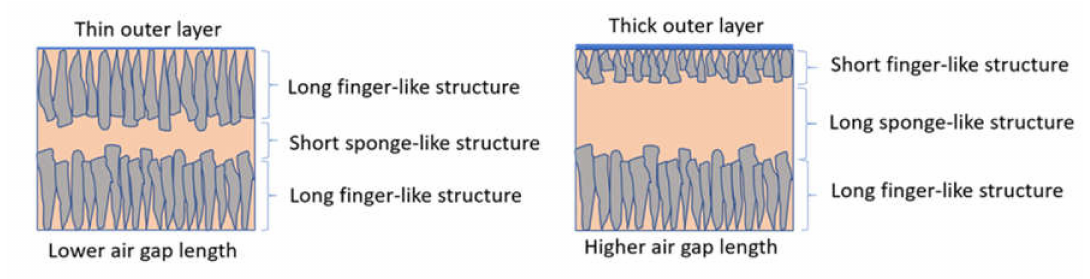
Figure 8. Schematic illustration of the e ff ect of air gap on DLHF membrane structure.